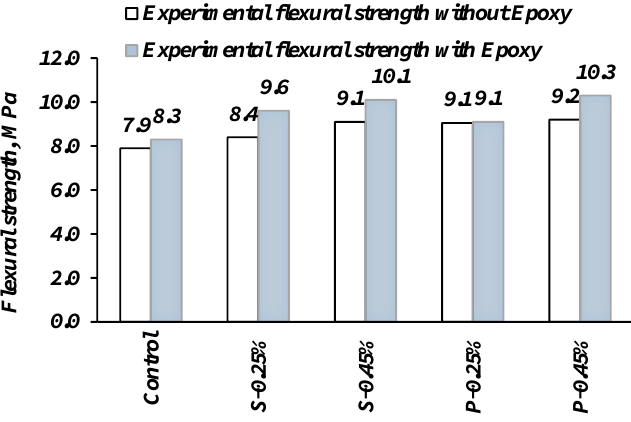
Figure 9. Effect of fibers on the flexural strength.